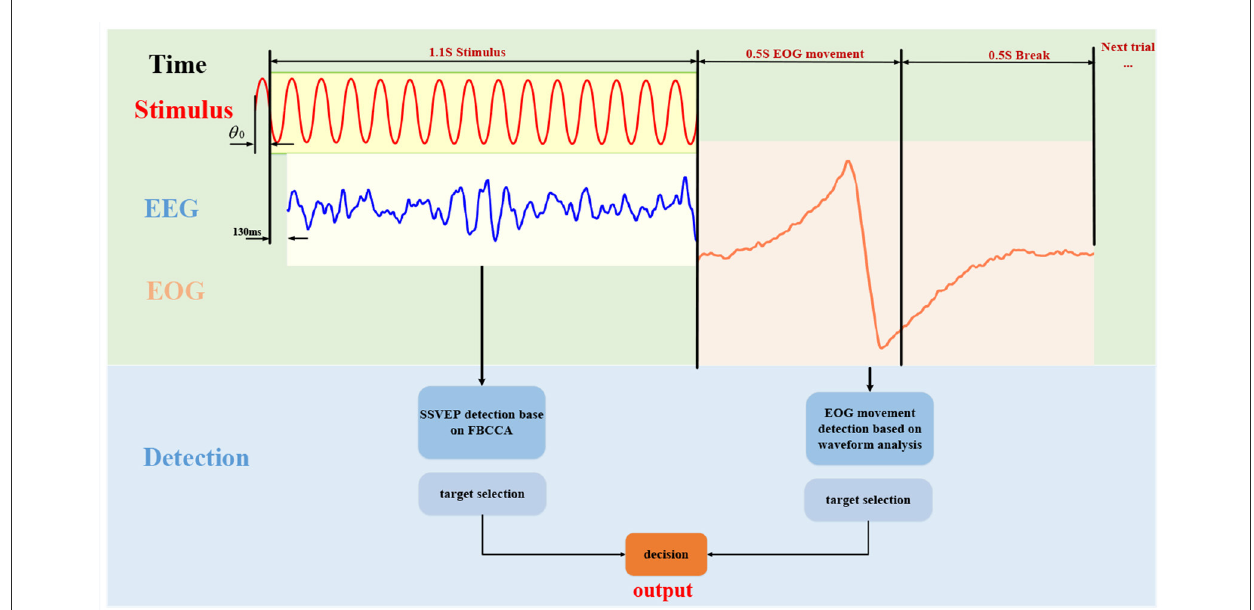
FIGURE3 The online experiment process of the hybrid BCI system proposed in this paper. Firstly, 1.1 s of EEG data is acquired for SSVEP detection, and then 1s of EOG data (including 0.5 s of rest time EOG signals) is acquired for eye movement direction detection. A decision is made based on the results of the two detections, and the final output is obtained.